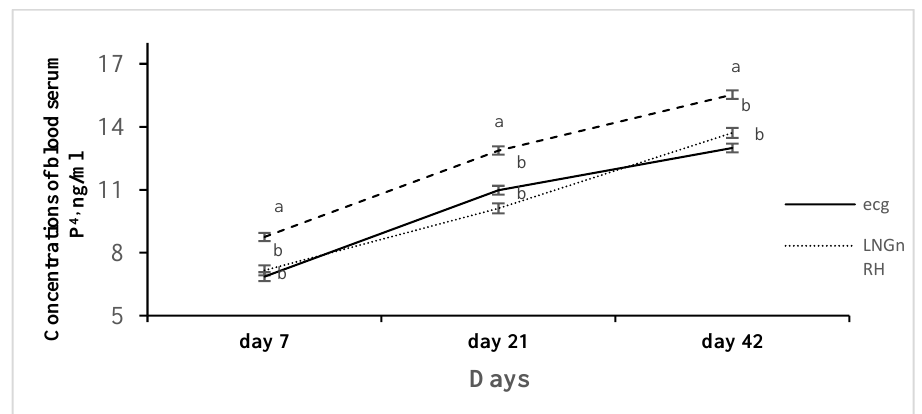
Figure 3. Concentrations of blood serum progesterone (P 4 , ng/mL), measured on day 7 (mid-luteal